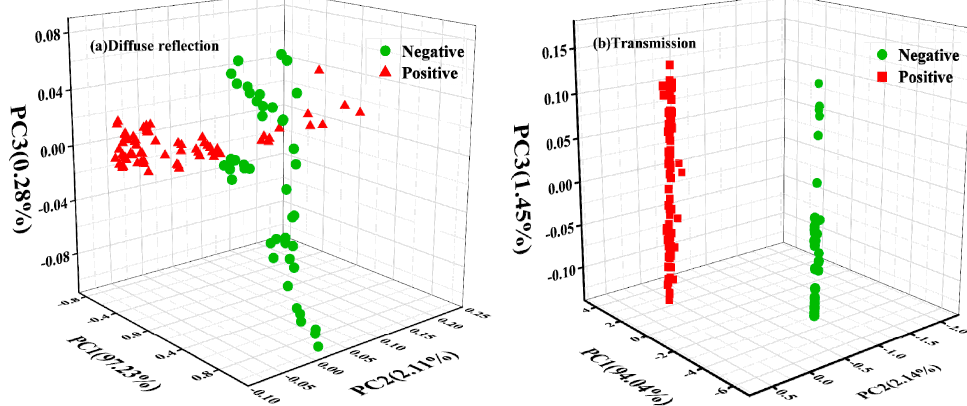
Figure 4. Scores of the first three principal components.